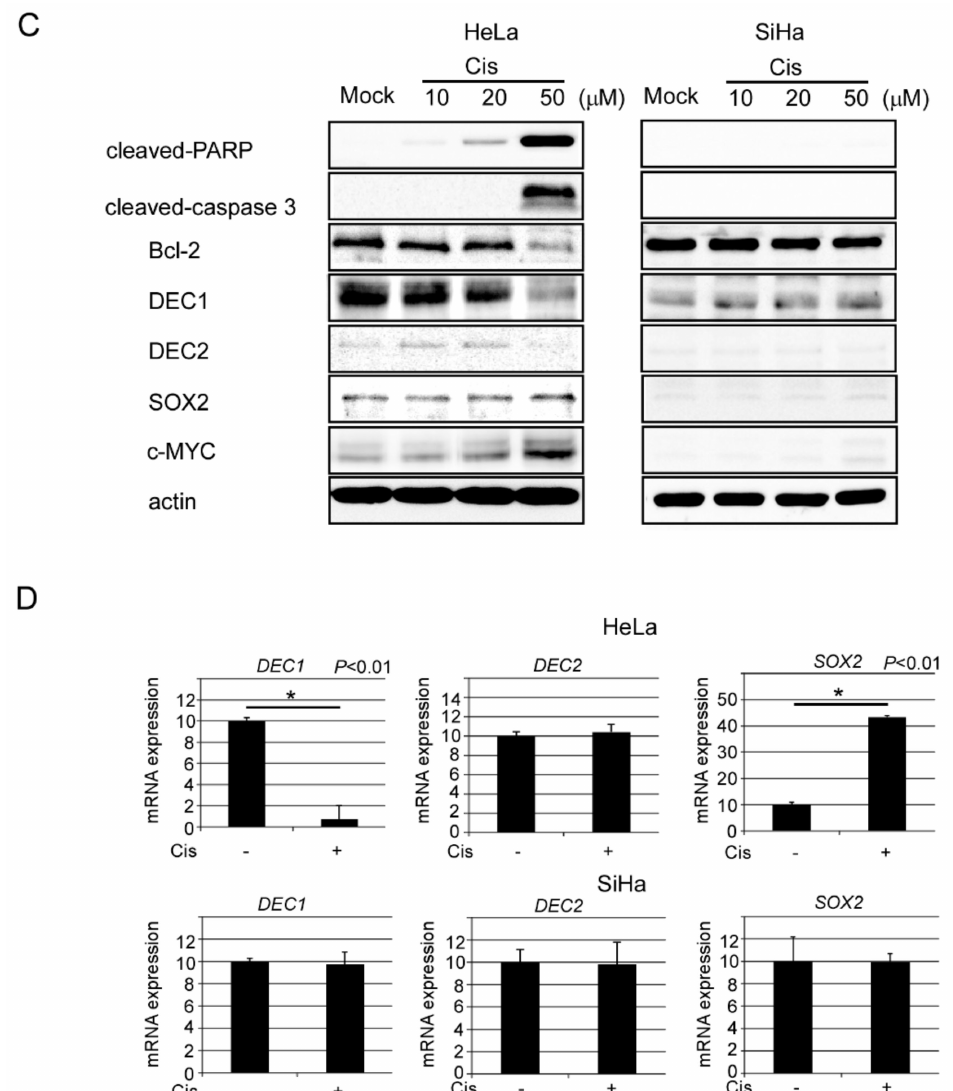
Figure 2. DEC1 expression decreases in HeLa cells under apoptosis. ( A ) Endogenous DEC1 protein expressions in HeLa and SiHa cells. Western blotting images of β -catenin, DEC1, DEC2, SOX2, c-MYC and actin in HeLa and SiHa cells. The western blot analysis was repeated three times and similar results were obtained. ( B ) Cell viability of HeLa and SiHa cells with ( + ) or without ( − ) cisplatin treatment was determined. The absorbance (OD 480 / OD 650 ) at 0 and 24 h is shown. The value of cell viability of control 0 h regarded as 10, which means each basal value without treatment. Data are expressed as mean values ± SE (bars) of three independent samples. * p < 0.01, as determined using Dunnett’s test. Cis: Cisplatin treatment. ( C ) Western blotting images of cleaved-poly (ADP-ribose) polymerase (PARP), cleaved-caspase 3, Bcl-2, DEC1, DEC2, SOX2, c-MYC and actin treated with 10, 20, and 50 µ M cisplatin or mock in HeLa and SiHa cells. The western blot analysis was repeated three times and similar results were obtained ( D ) DEC1 , DEC2 and SOX2 mRNA expressions in HeLa and SiHa cells with ( + ) or without ( − ) cisplatin treatment. Data are expressed as mean values ± SE (bars) of three independent samples. * p < 0.01, as determined using t-test. qPCR was repeated three times and similar results were